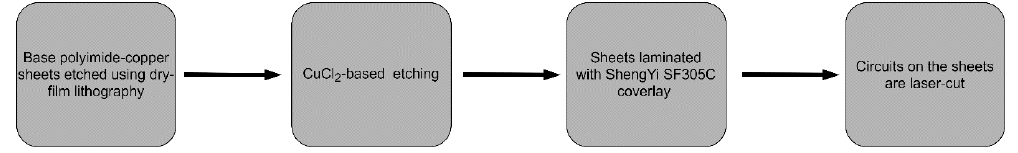
Figure 1. The copper processing flow chart.